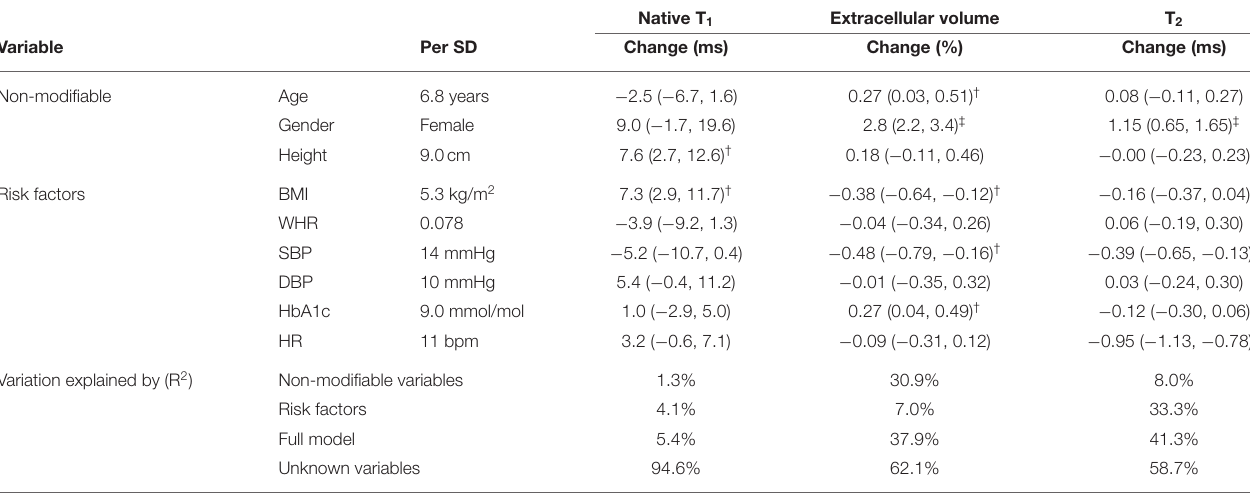
TABLE 3 | Multivariate linear regression models for myocardial tissue